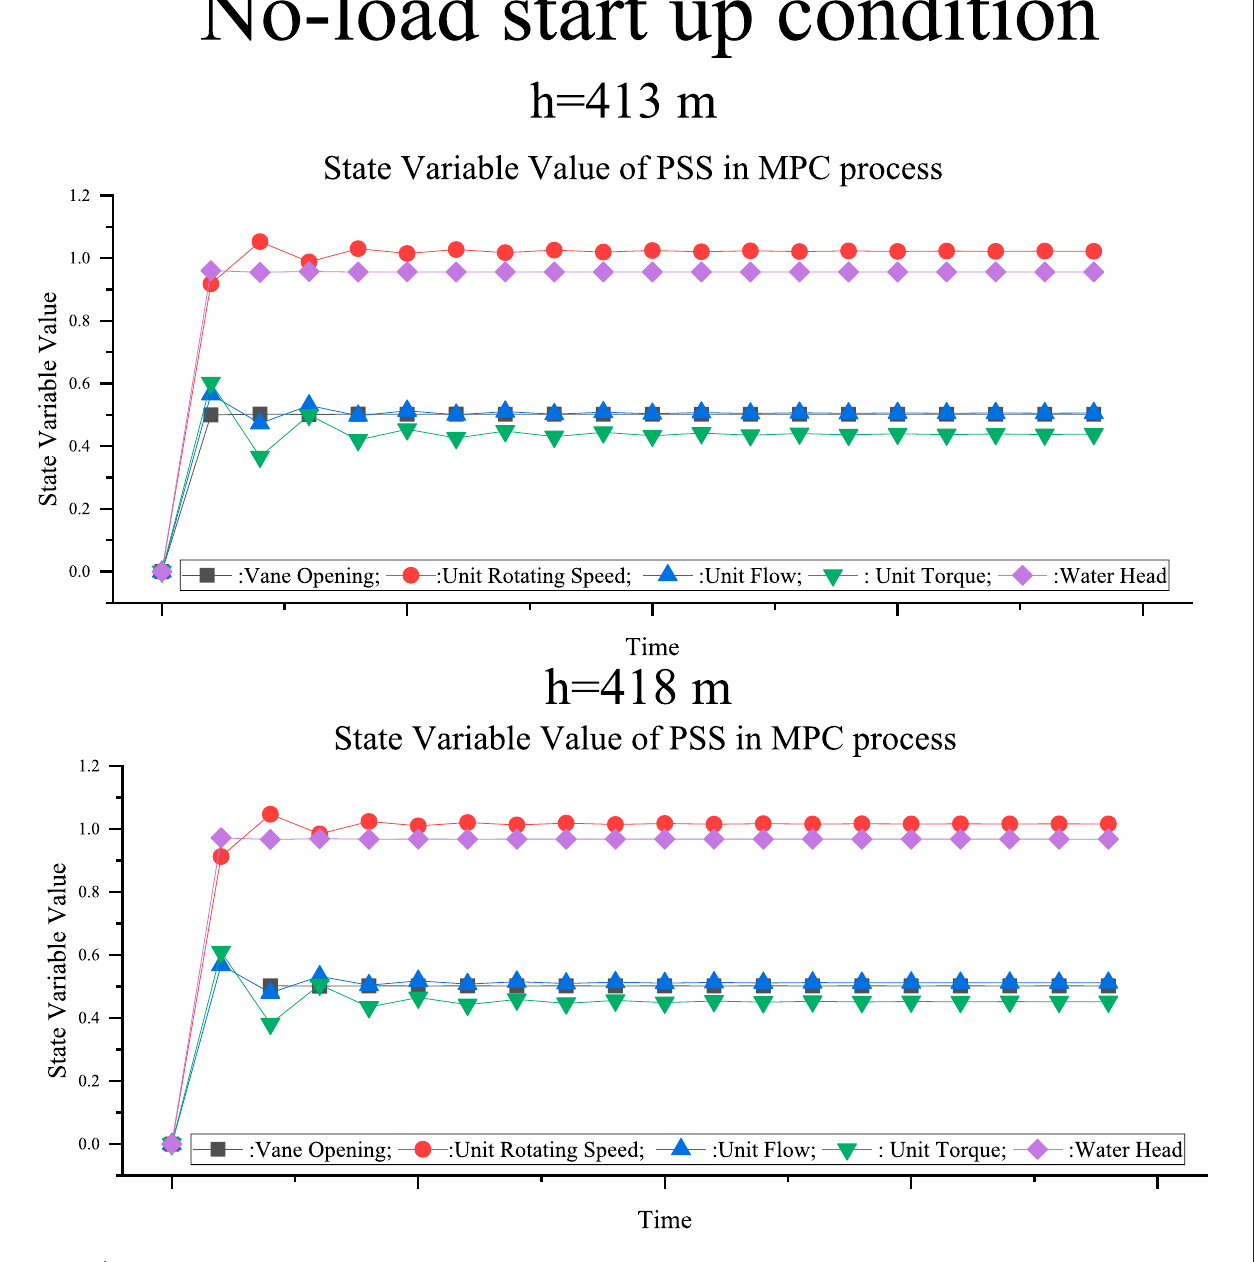
FIGURE 10 | PSS MPC state variables during no-load start-up under 413 and 418 m of water head.